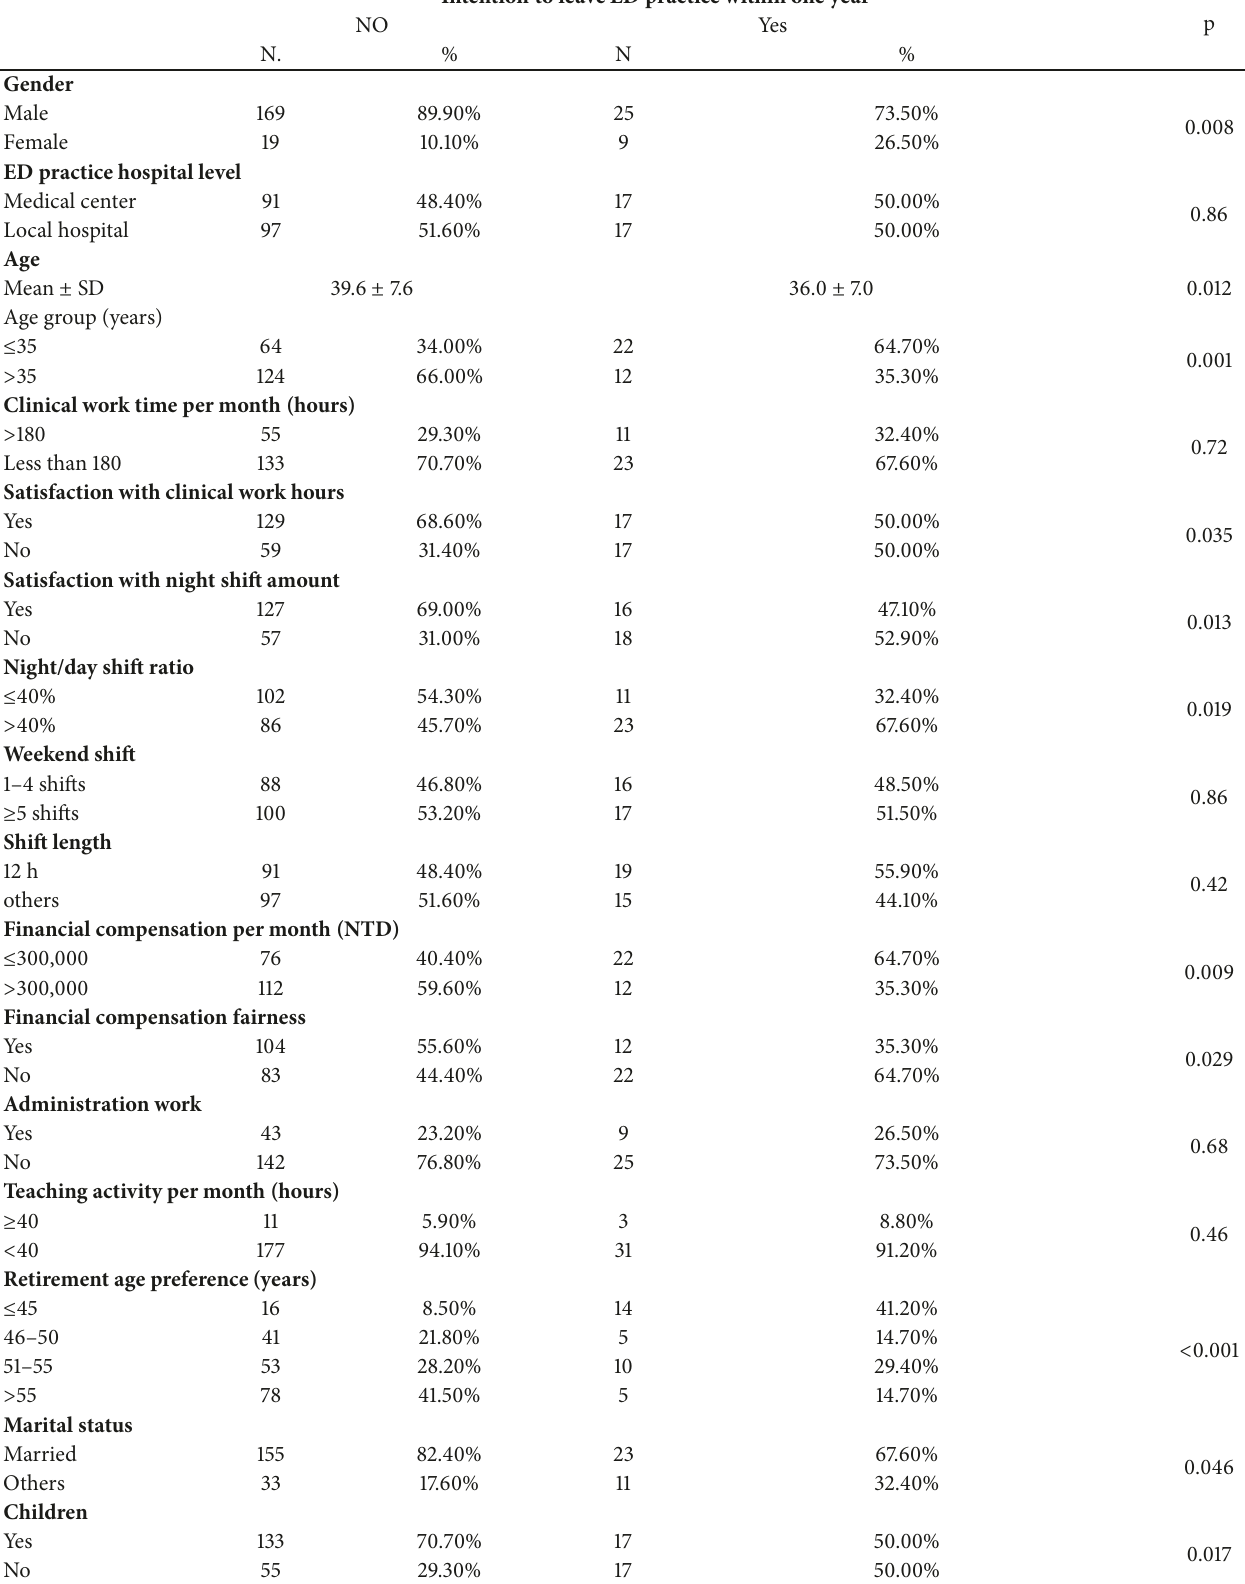
Table 2: Characteristics associated with emergency physicians who planned to leave emergency department (ED) practice within one